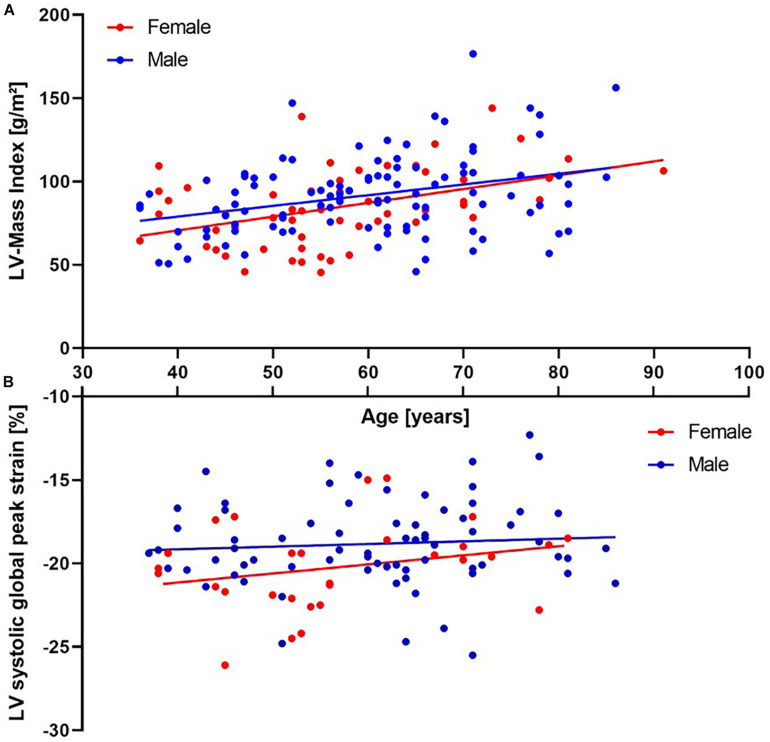
(A, upper panel) – scatter plot of left ventricular (LV) mass index plotted against age including regression lines for groups. Note the significant increase in both sexes with age (Correlation coefficient 0.37, p < 0.01). Mean values do not differ between groups. (B, lower panel) – scatter plot of LV systolic global peak strain plotted against age including regression lines for groups. Strain values do not correlate with age in both groups, whereas mean values differ significantly between groups (p = 0.01).